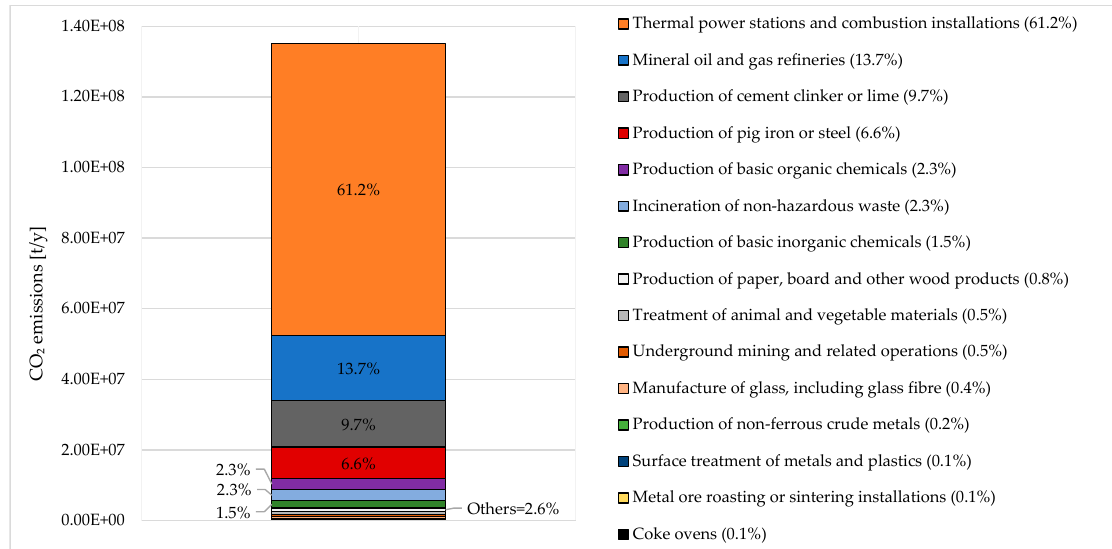
Figure 1. Aggregated CO 2 releases from industrial activities in Italy (2017): sector breakdown. Adapted from [24].